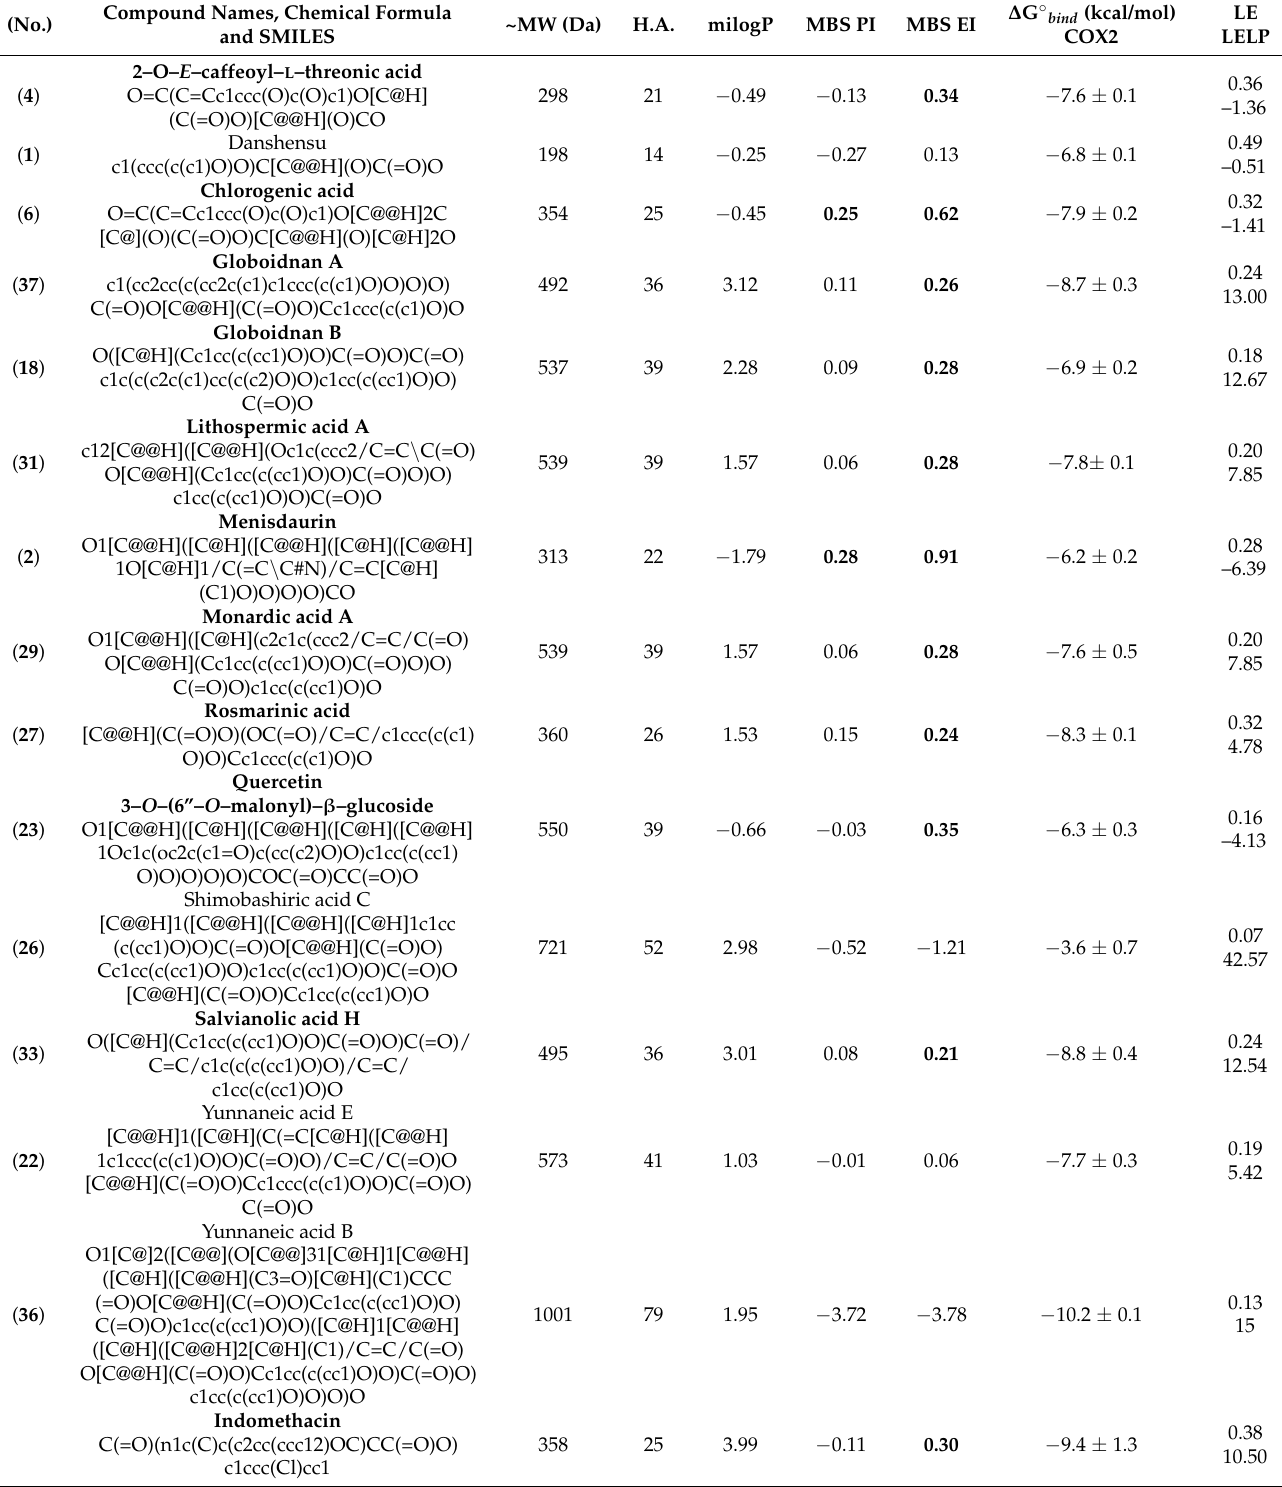
Table 8. Summary of computational analysis of the most abundant compounds found in P. obscura and P . officinalis . MW– predicted molecular weight, MBS, HA–the number of heavy atoms, PI–Protease inhibitor Molinspiration bioactivity score v2014.03, MBS EI–Enzyme inhibitor Molinspiration bioactivity score v2014.03, ∆ G ◦ –predicted standard free energy of ligand binding, LE-Ligand Efficiency (LE = –RTlnK d /HA or – ∆ G ◦ /HA), LELP = milog P/LE. The most probable inhibitors and indomethacin are marked in bold. Locations of docking of two the most potent COX inhibitors, i.e., menisdaurin and salvianolic acid H as well as indomethacin (a reference COX inhibitor) are visualized in Figure